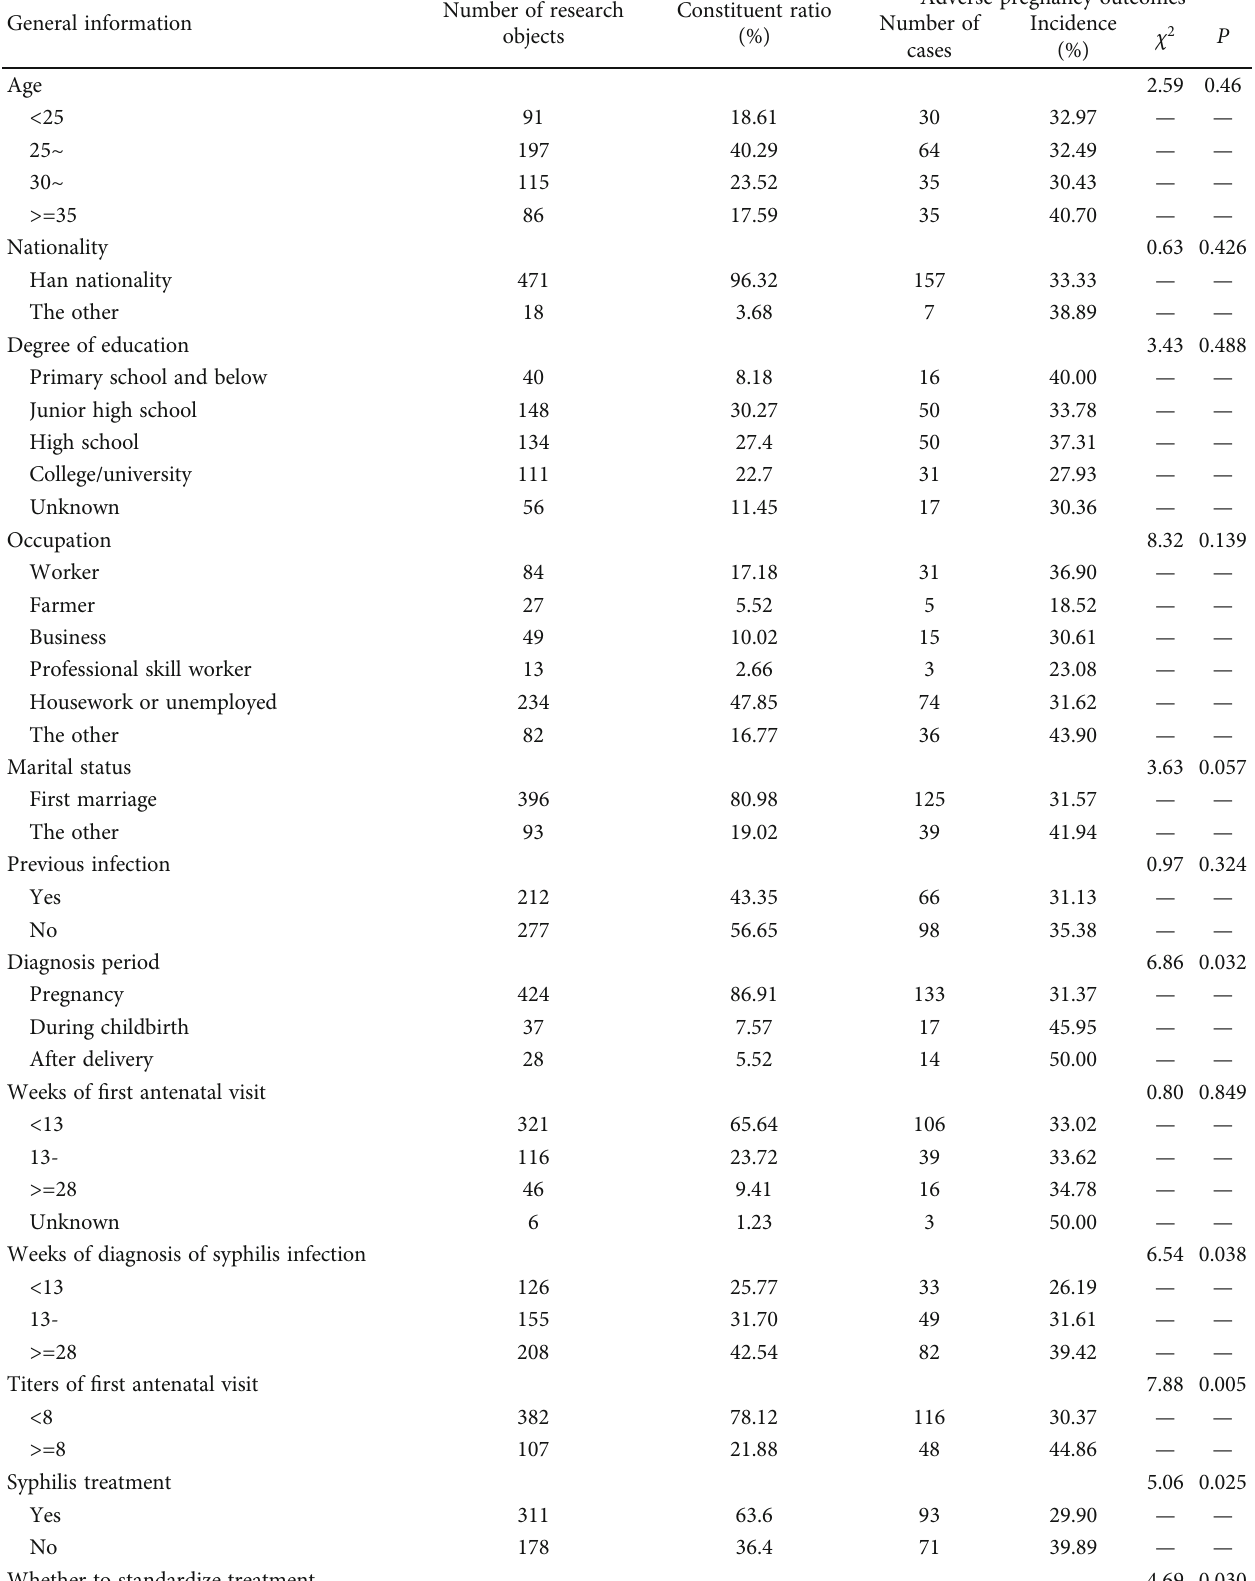
Table 1: General information of the research objects and comparison of the incidence of adverse pregnancy